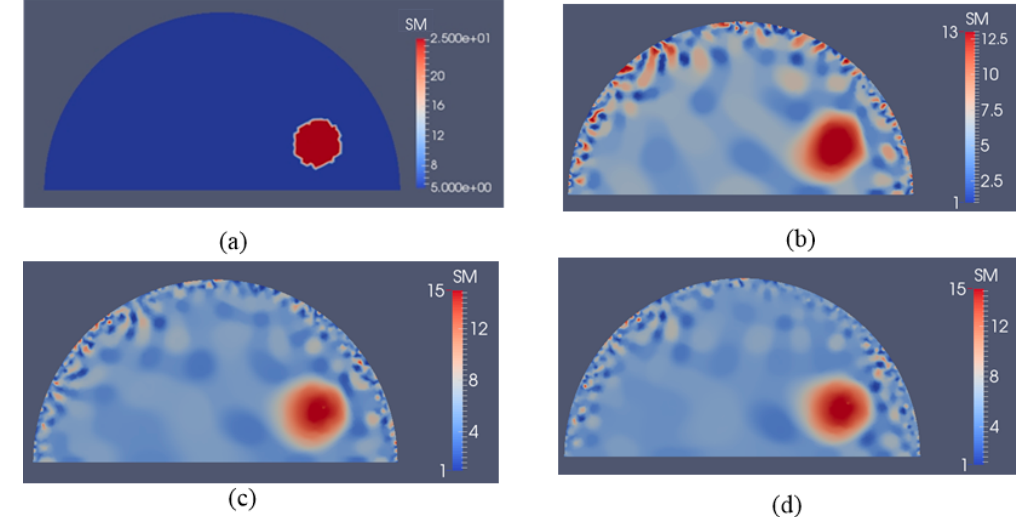
Figure 6. Shear modulus reconstructions with 1% noise. ( a ) target shear modulus distribution for comparison; ( b – d ) reconstructed shear modulus distribution using 5, 10, and 15 boundary displacement data sets, respectively (unit in the scale bar: kPa). Note: “SM” stands for shear modulus.